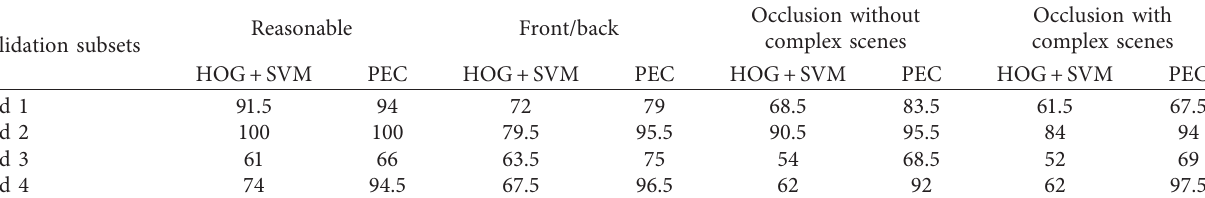
Table 4: Performance comparison on INRIA and PSU datasets (average precision %).